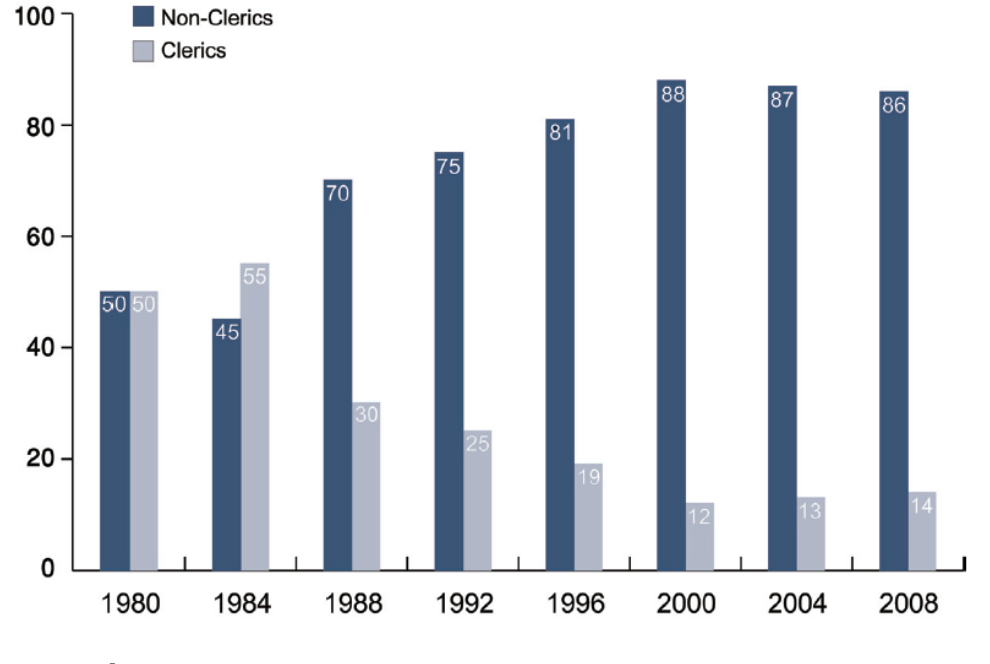
Figure 2: Iranian Parliament Members - Clerics versus Non-Clerics (%), 1980-2008